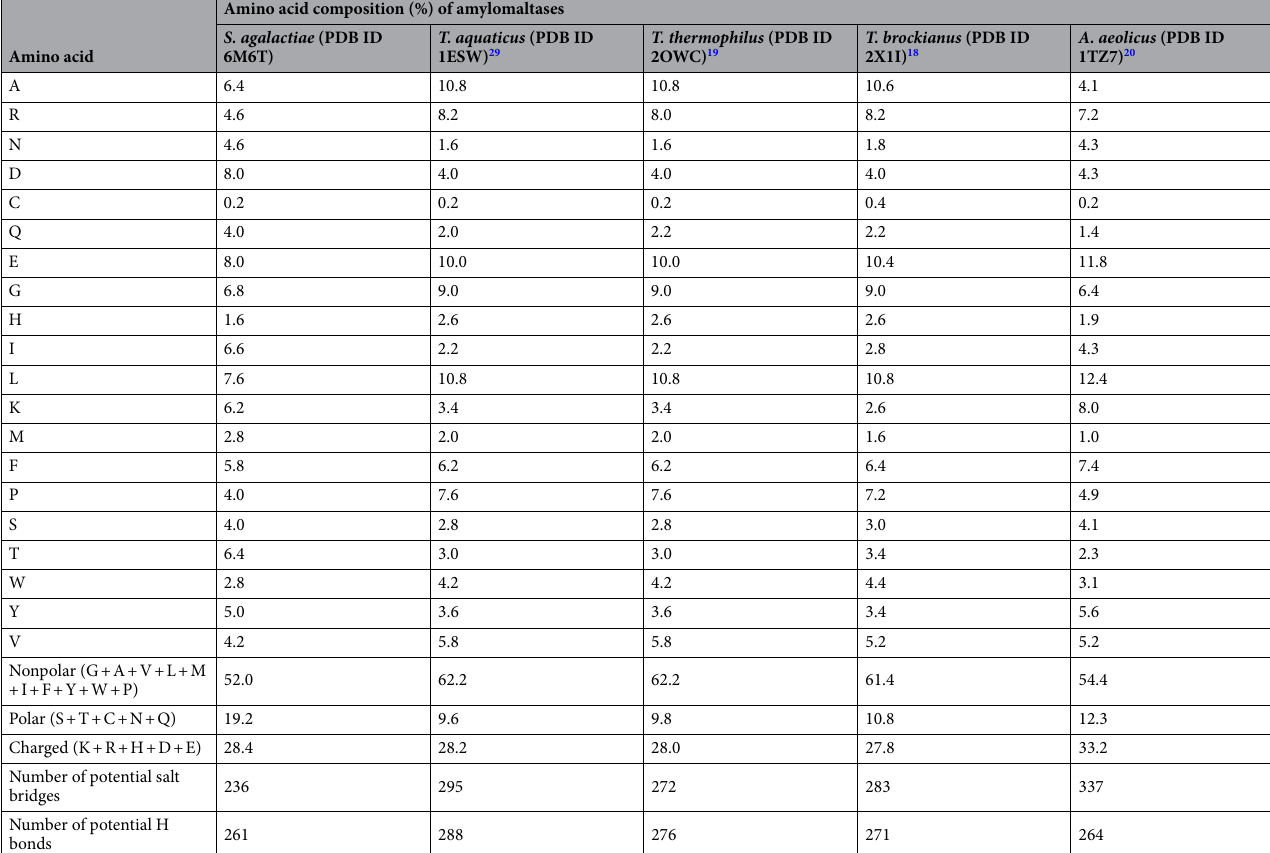
Table 5. Amino acid compositions, number of potential salt bridges and H-bonds among